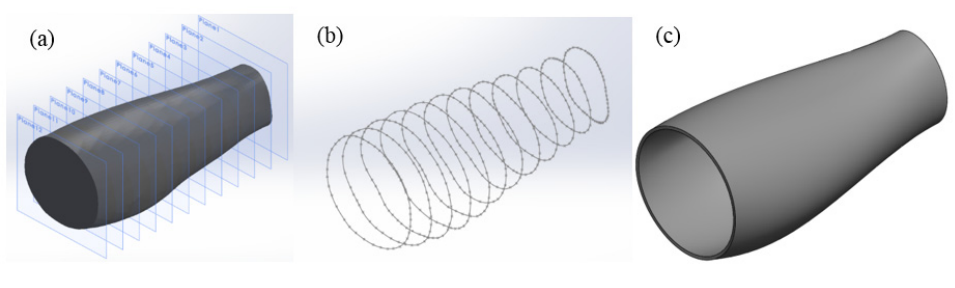
Figure 2. Key steps to obtain the final solid model. ( a ) Cutting planes; ( b ) splines; ( c ) loft, offset and thicken the surface.